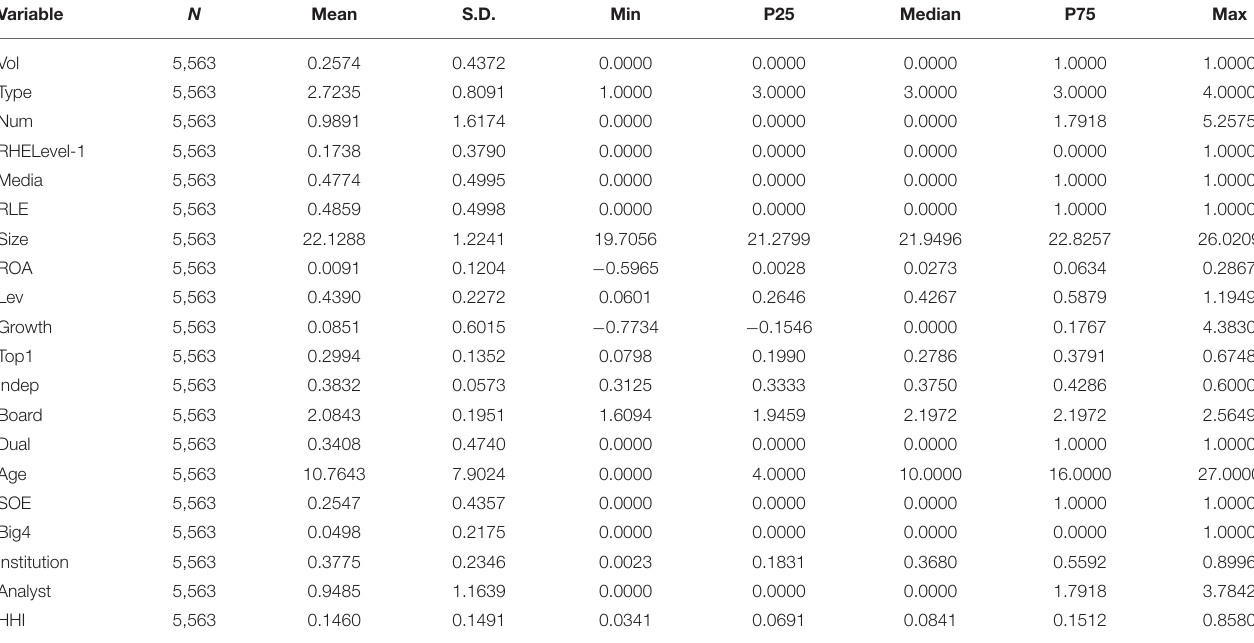
TABLE 2 | Descriptive